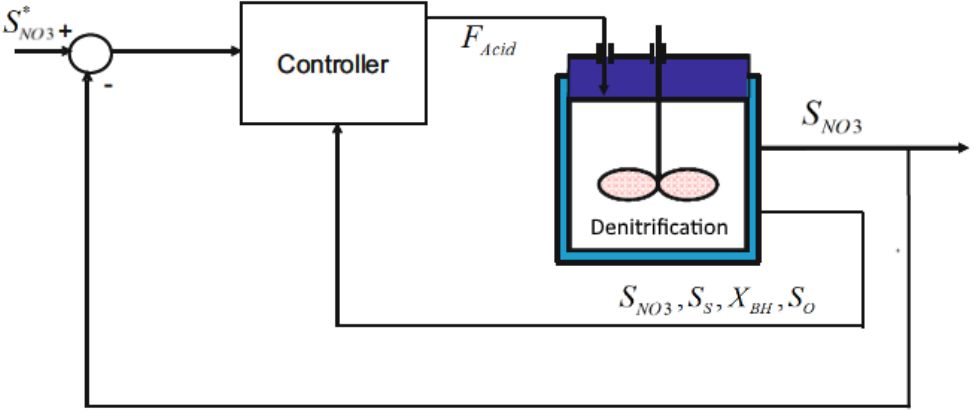
Figure 11. Linearizing control